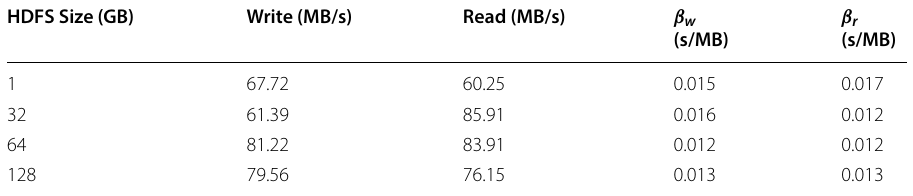
Table 1 The estimated β r and β w values for different HDFS file sizes